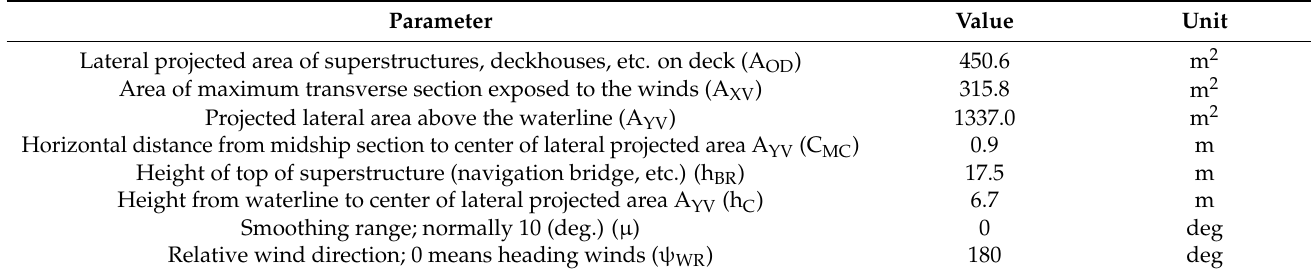
Table 7. Non-wetted surface parameters required for the Fujiwara regression method.